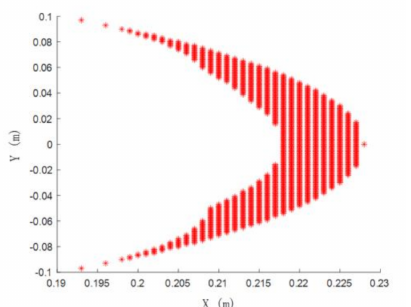
Figure 9. The workspace of experimental